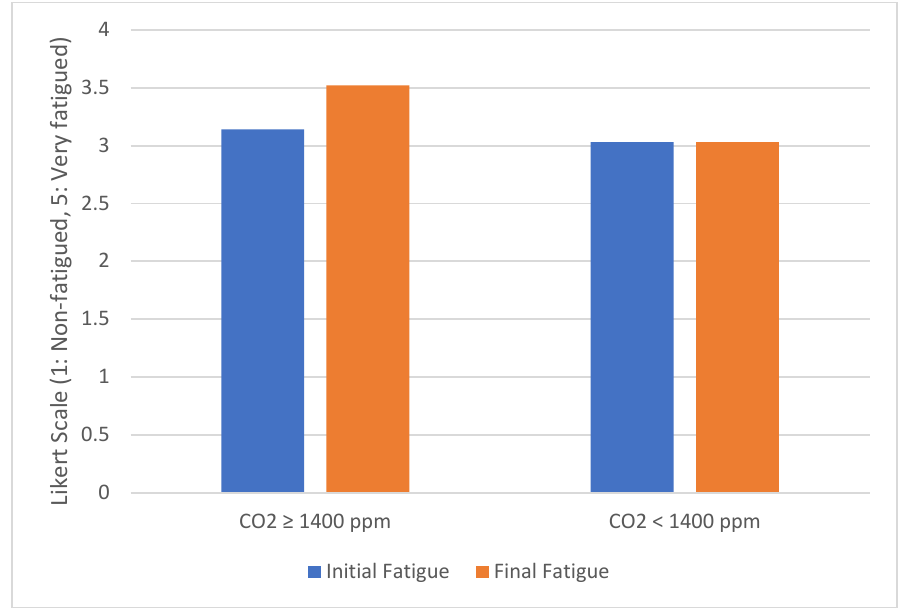
Figure 9. Evolution of fatigue grouped by CO 2 level.